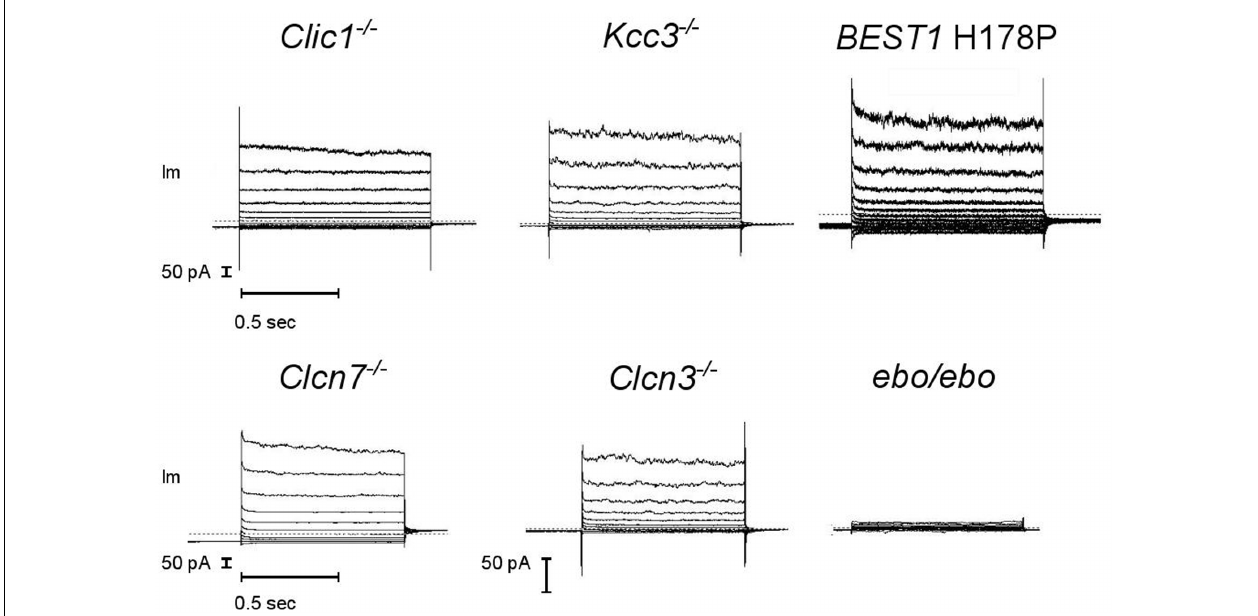
FIGURE 7 | A robust dialysis activated Cl – current is recorded from mouse neutrophils lacking a range of Cl – transport pathways but it is much reduced in LRRC8A deficient cells. CLIC1 – / – , KCC3 – / – , CLCN3 – / – and ebo/ebo recordings are from bone marrow derived neutrophils, CLCN7 – / – recordings are from mouse blood neutrophils, BEST1 H178P recordings are from human neutrophils. Representative examples, n ≥ 3 for each subtype. Experiments were carried out using solution Set E ( Table 1